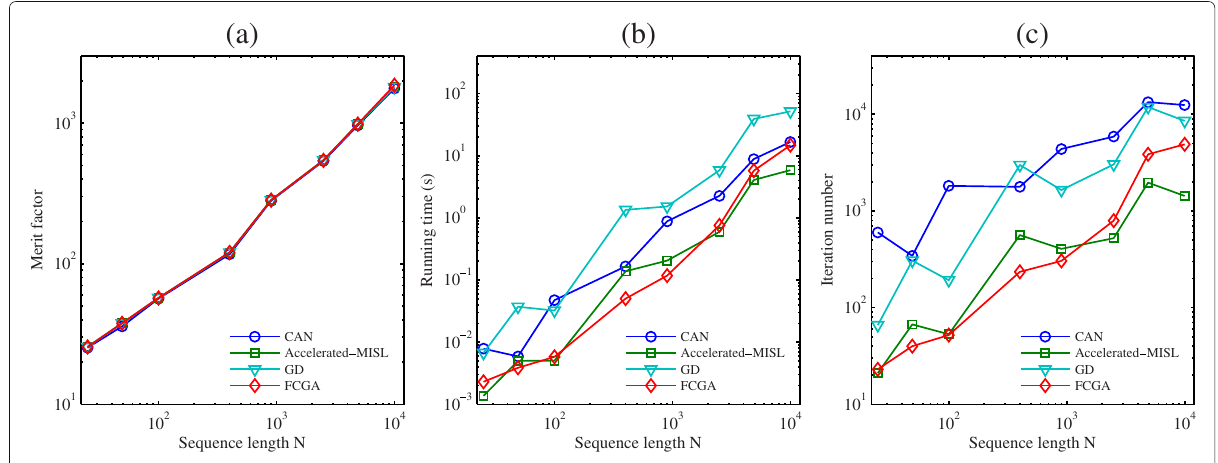
Fig. 6 a – c The performance metrics of different algorithms initialized by Frank sequence